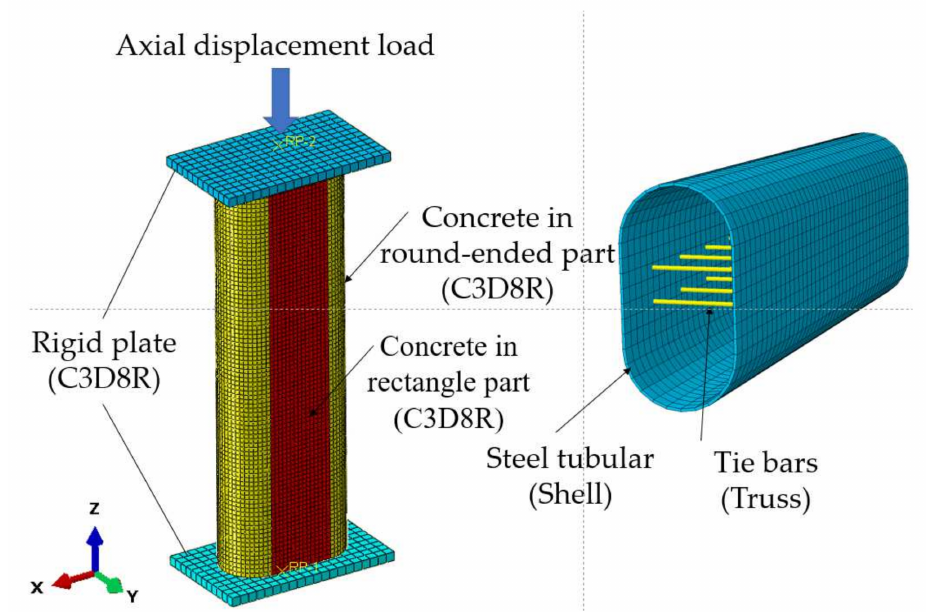
Figure 5. Finite element model of